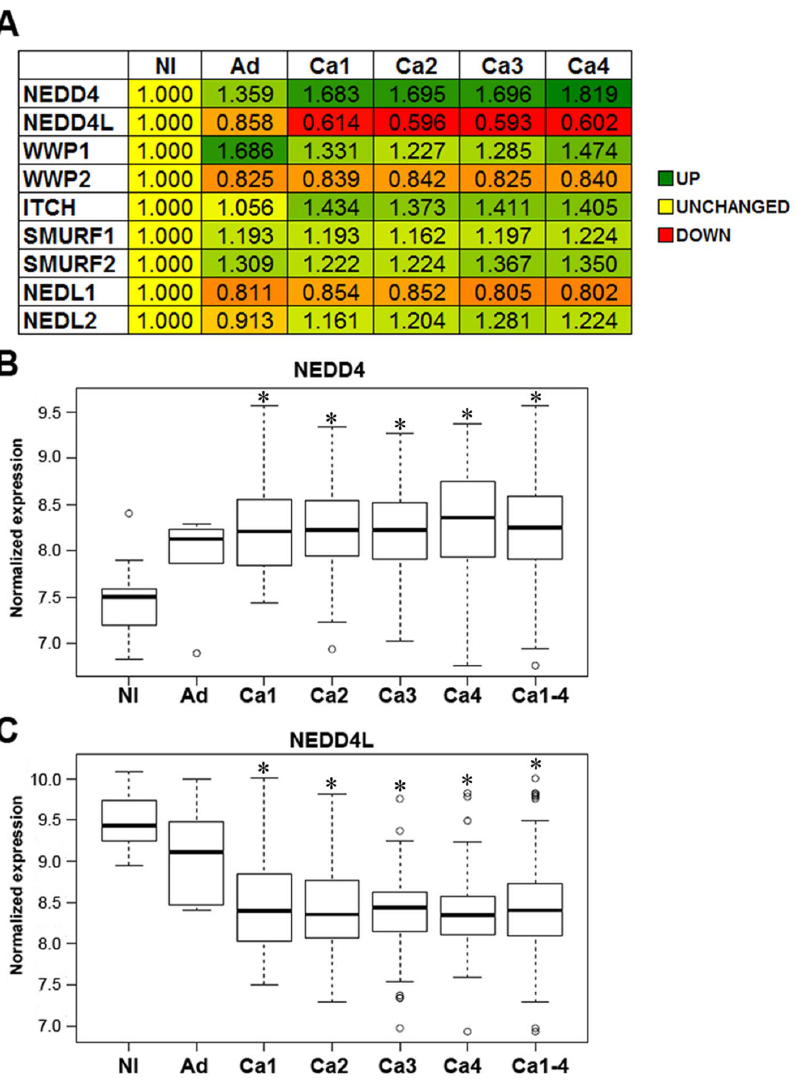
Figure 2. Expression levels of the NEDD4 family in CRC. (A) The expression of all nine NEDD4 family members was examined in CRC by microarray profiling. Shown here is the average fold-change of all probes for each individual gene in Nl (N=10), Ad (N=6), Ca1 (N=33), Ca2 (N=76), Ca3 (N=82), and Ca4 (N=59). (B) NEDD4 (213012_at) is the most highly upregulated member of the NEDD4 family in CRC. (C) NEDD4L (212445_s_at) is the most highly downregulated member of the NEDD4 family in CRC. Nl= normal, Ad= adenoma, and Ca1-4=CRC, stage I-IV. *p ,